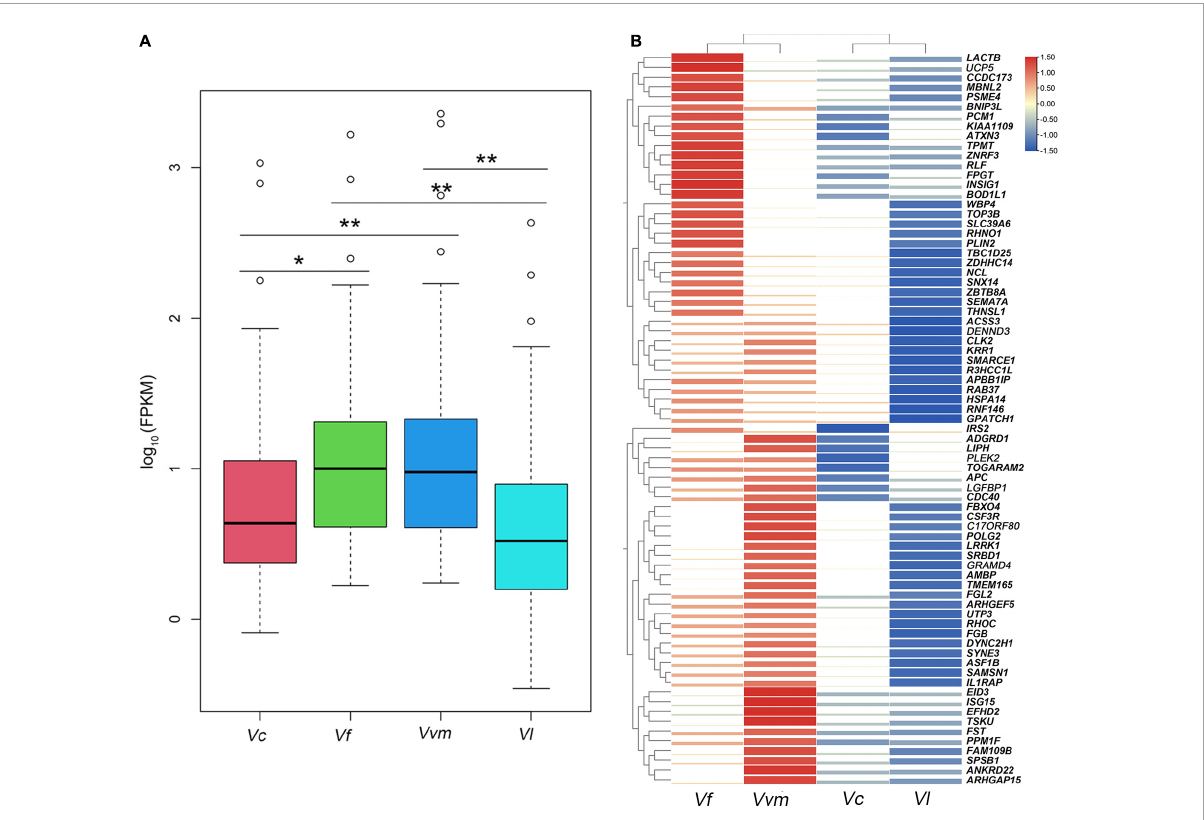
FIGURE4 Seventy five differential expressed genes showed significantly higher expression levels in the high-altitude group compared with the low-altitude group. (A) Box-plot analysis presented a significantly higher expression levels in the high-altitude group of these 75 differential expressed genes. * p < 0.05, and ** p < 0.01. (B) Heat-map analysis of 75 differential expressed genes. The heat map was generated using hierarchical clustering. Distances, representing the relative similarity among genes and Vulpes , were calculated using Pearson’s correlation coefficients. Color represents FPKM value of gene expression after scaling and centering.